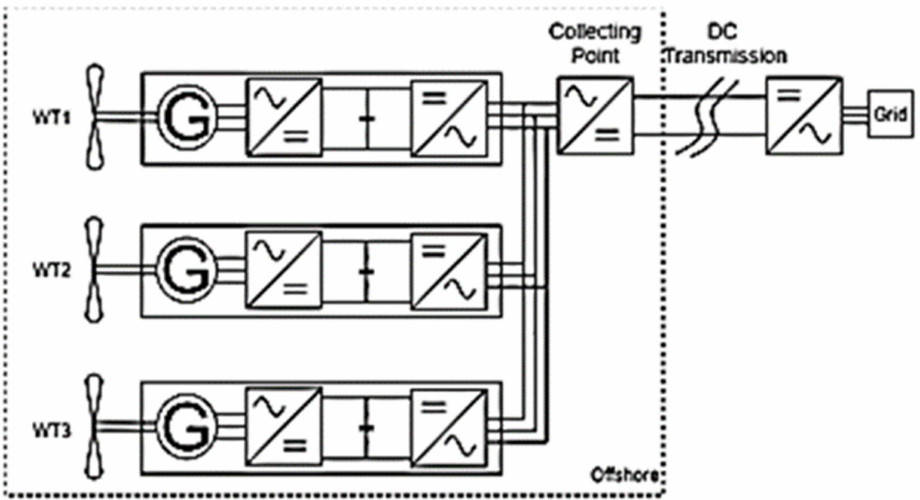
Figure 5. Standard PMSG AC/DC offshore wind farm circuit topology [Reprinted/adapted with permission from Ref. [5]. 2021,